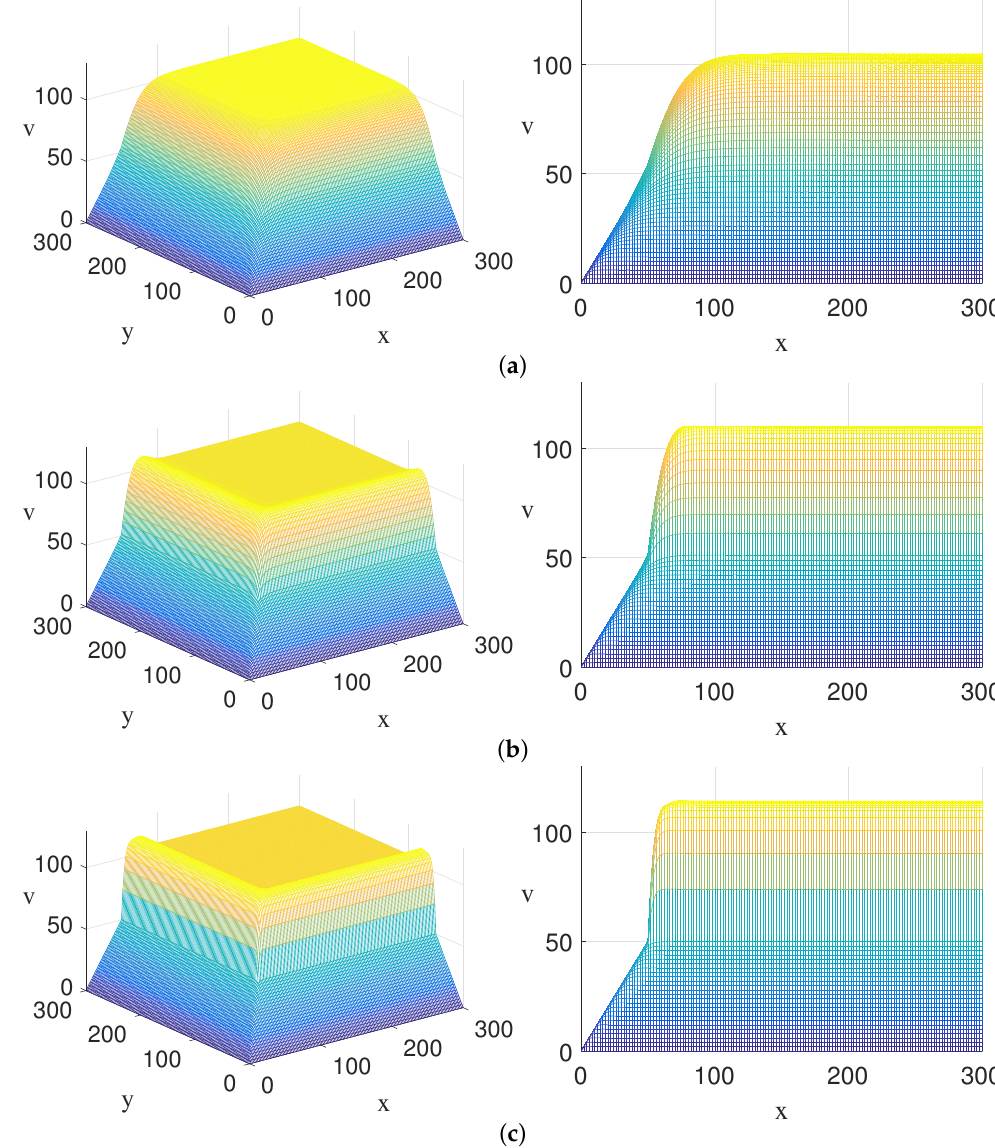
Figure 6. ( a ) denotes v for different x , y when H x = H y = 0.3, ( b ) denotes v for different x , y when H x = H y = 0.5 and ( c ) denotes v for different x , y when H x = H y =